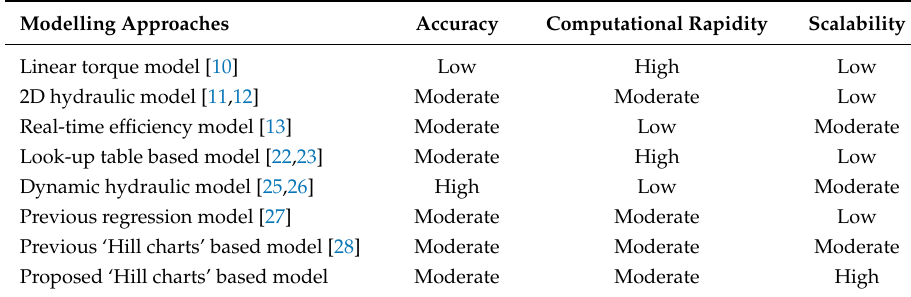
Table 1. Comparisons of different modellings for their implementations on PHIL